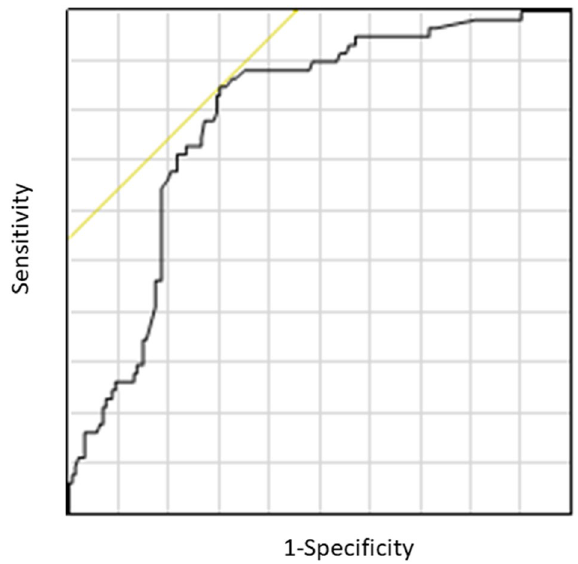
Figure 2. Receiver operating curve (ROC) analysis based on the ALR for the tumor response. In this model, the sensitivity was 85.0%, the specificity was 70.0%, and the AUC was 0.790. p < 0.001. AUC, area under the curve.